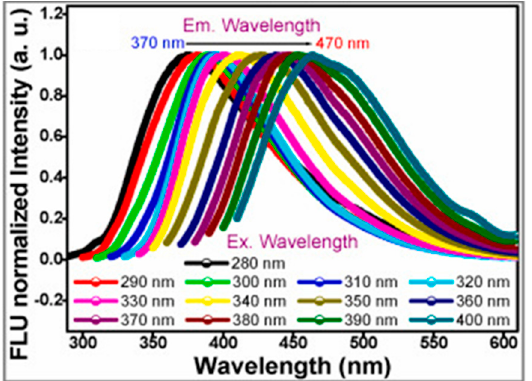
Figure 5. Red shift of green emitting BCCDs as reported in [95] . Reprinted with all permissions from Elsevier.